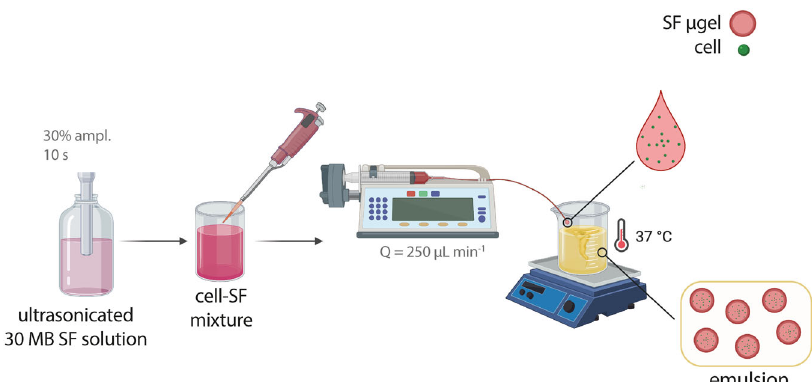
Fig. 1 Schematic for the production of cells-SF µgels by water-oil emulsion procedure. Image created with